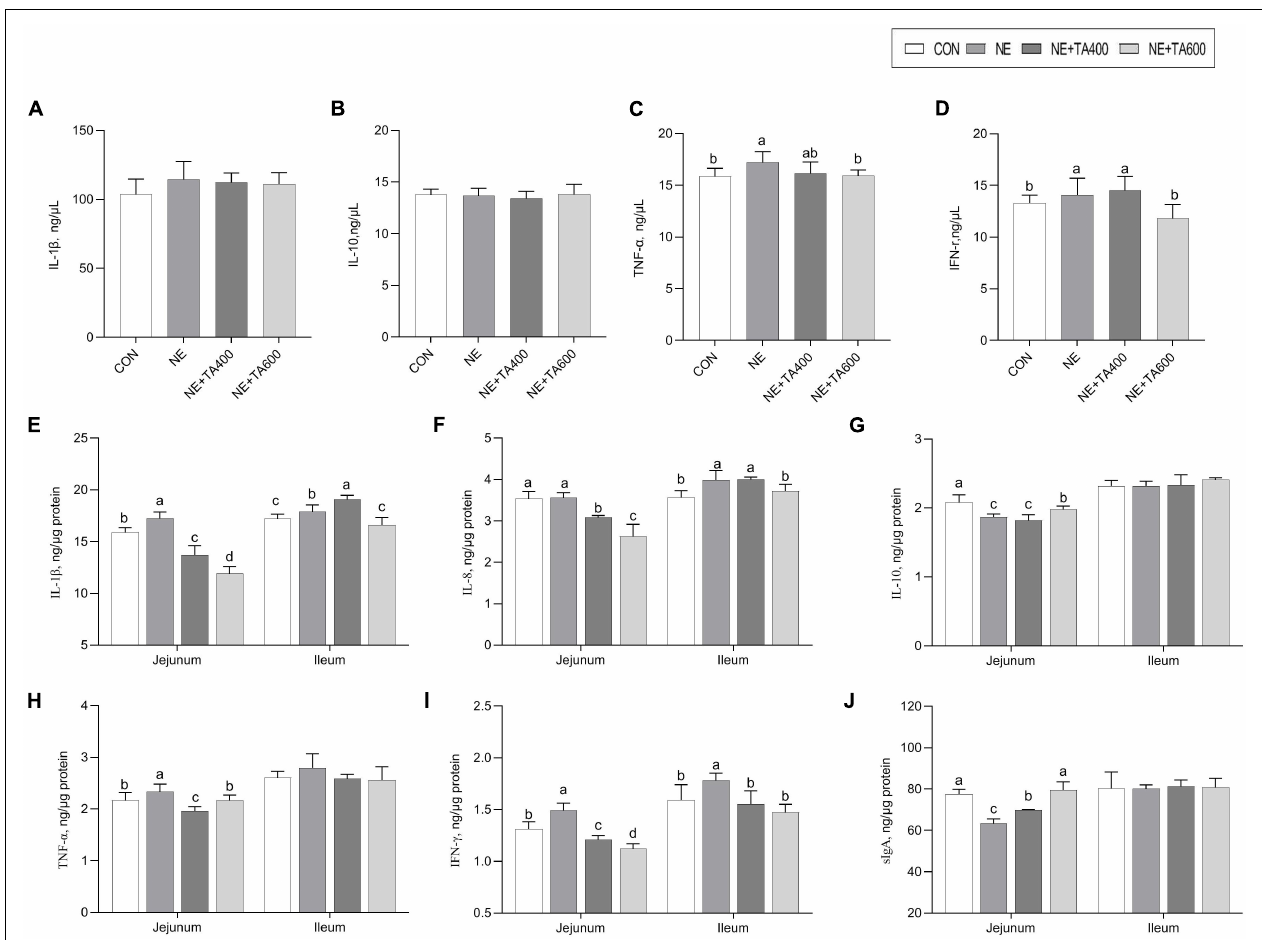
FIGURE 4 | The effects of TA on the concentration of inflammatory cytokines and sIgA of subclinical NE broilers. (A–D) The serum concentration of IL-1 β , IL-10, TNF- α , and IFN- γ ; (E–I) jejunal and ileal concentration of IL-1 β , IL-8, IL-10, TNF- α , and IFN- γ ; (J) Jejunal and ileal sIgA concentration. Values were expressed as mean with standard error represented by vertical bars. a , b Means with different letters differ significantly among the groups ( P < 0.05). IL-1 β , interleukin-1 β ; IL-8, interleukin-8; IL-10, interleukin-10; TNF- α , tumor necrosis factor- α ; IFN- γ , interferon- γ ; sIgA, secretory immunoglobulin